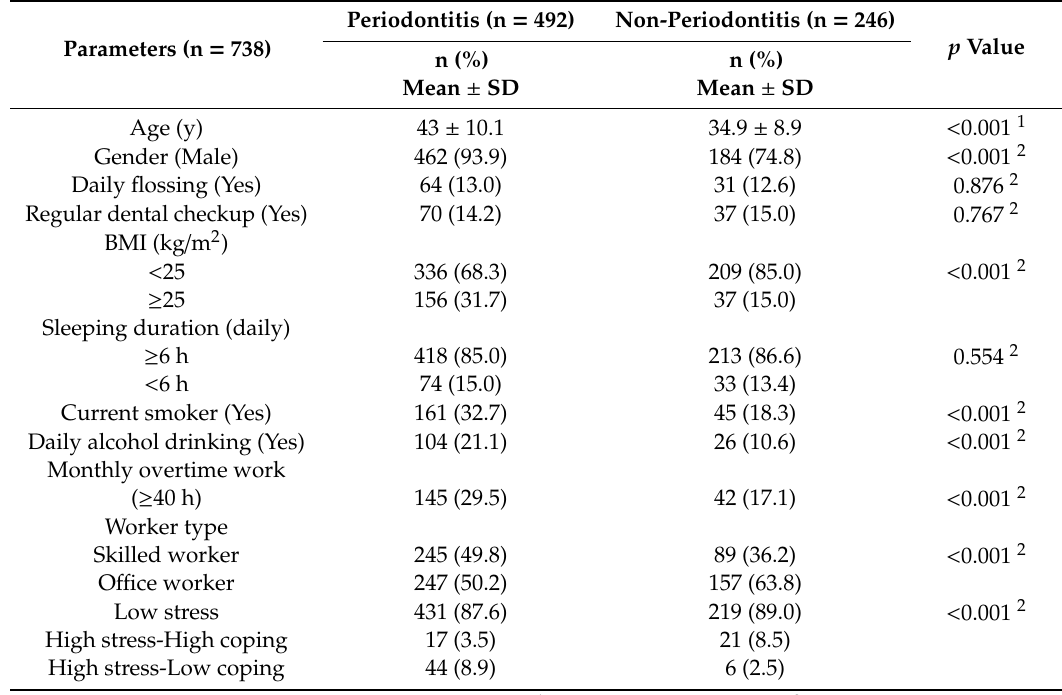
Table 2. Comparisons of the between periodontitis and non-periodontitis groups.